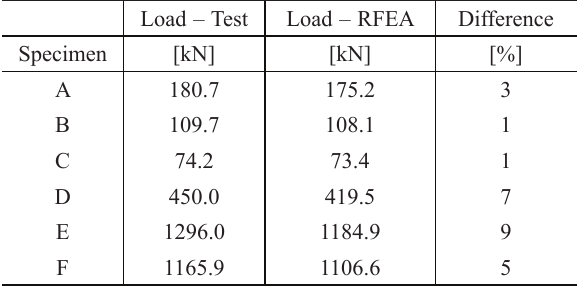
Table 3. Comparison of numerical tests against experimental